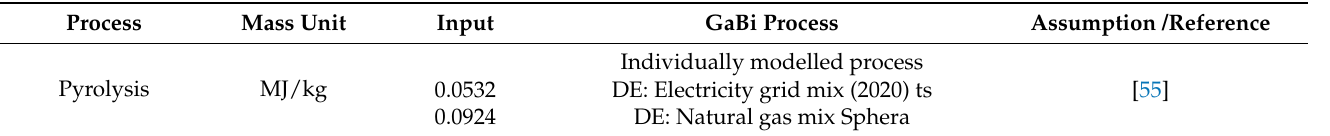
Table 3. Inventory pyrolysis.